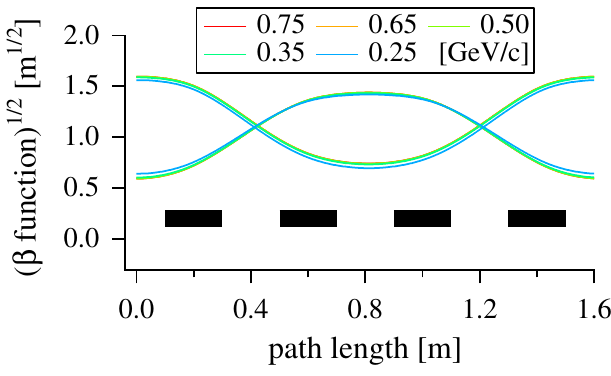
FIG. 4. (Color) Beta functions with different momenta in a unit cell which satisfies the periodic boundary condition. Rectangles at the bottom show the position of FDDF magnets.